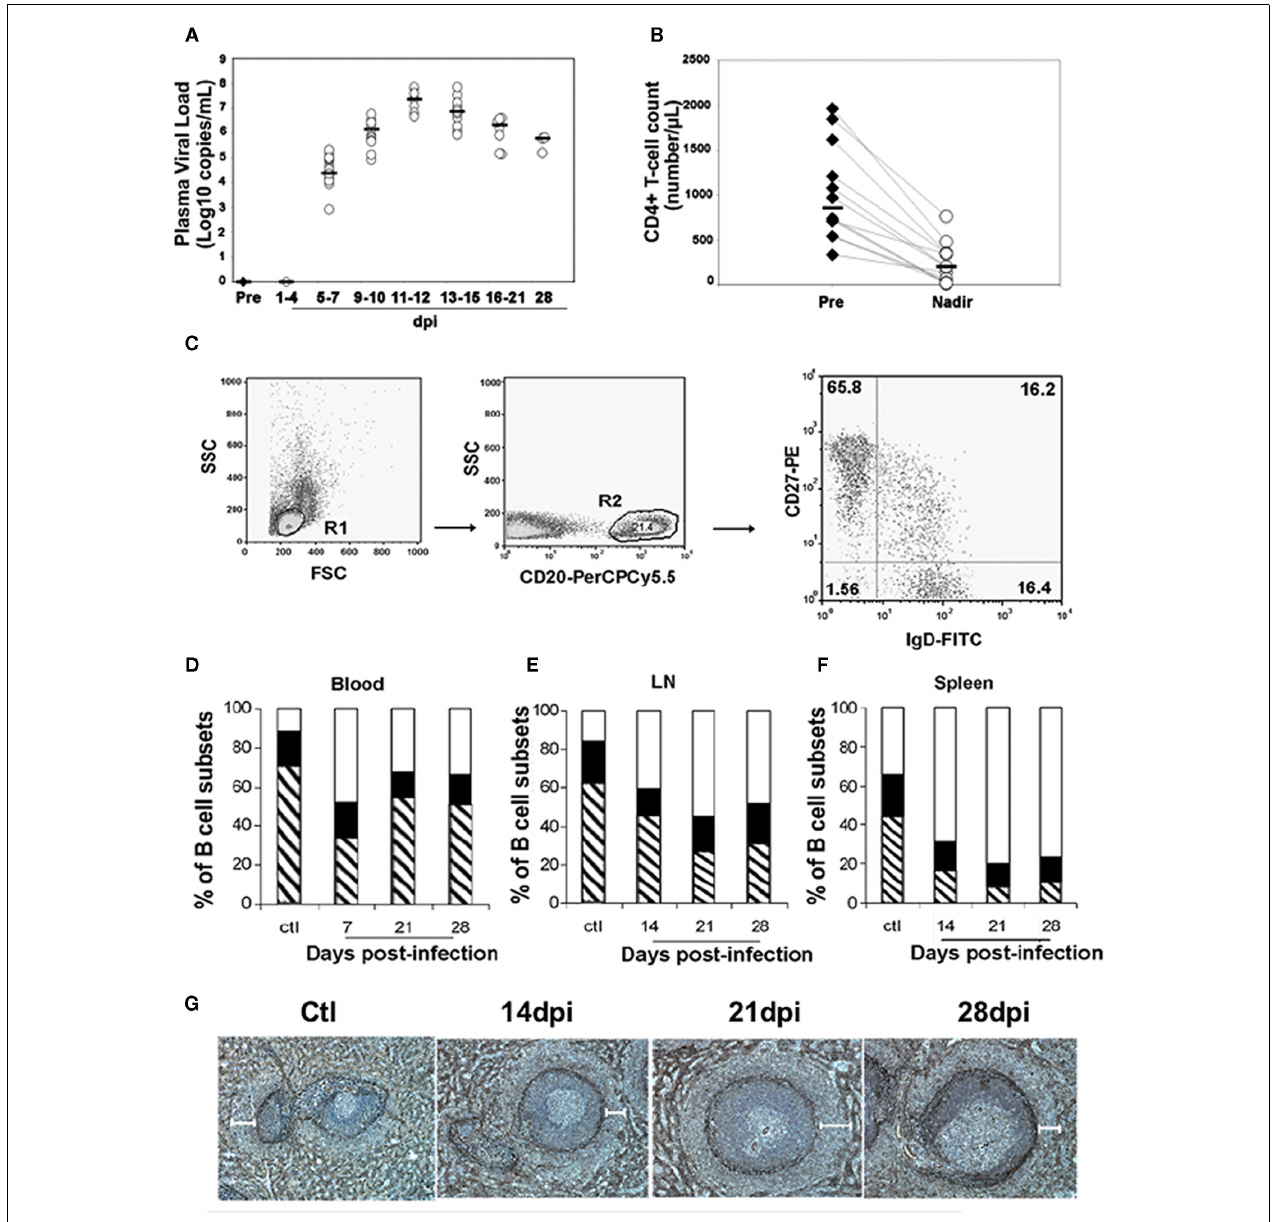
FIGURE 2 | Loss of MZ B-cells and switched memory B-cells during the acute phase of SIV infection. Macaques were infected intravenously with the pathogenic SIVmac251 strain. For each macaque, blood samples were taken before infection and every 3days post-infection (dpi).Three groups of five macaques were sacrificed 14, 21, and 28dpi. At euthanasia, spleen, peripheral blood, and mesenteric lymph nodes (LN) were collected from SIV-Infected animals and from four non-infected control animals. (A) Plasma viral load was determined by real-time PCR as described (Peruchon et al., 2009). Horizontal bars indicate median values. (B) Absolute numbers of blood CD4T-cells were determined in each animal as described (Peruchon et al., 2009) before infection and 11–12dpi when they reached their lowest values (nadir). Horizontal bars indicate median values. (C) CD27 and SIgD expression was studied by three-parameter immunofluorescence analysis on CD20-gated populations from various organs. Cells were gated on forward and side scatter (R1), and then on CD20 (R2) expression. CD27 and SIgD expression on CD20 + cells is shown on a representative dot plot of